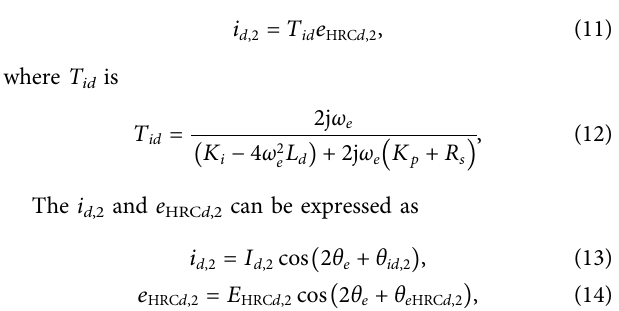
FIGURE 6 | 2nd-order components in d-axis current control